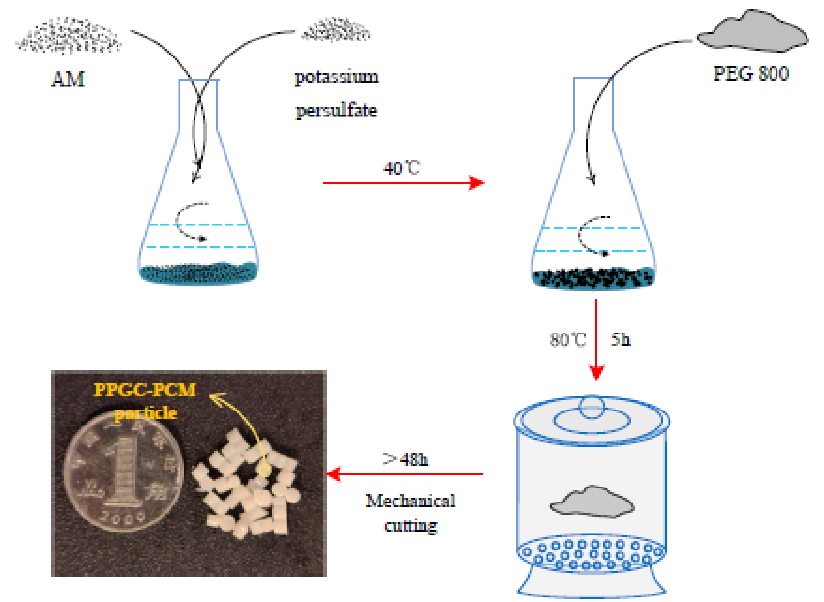
Figure 4. The preparation process of polyethylene glycol-polyacrylamide graft copolymer for cool pavement [53].